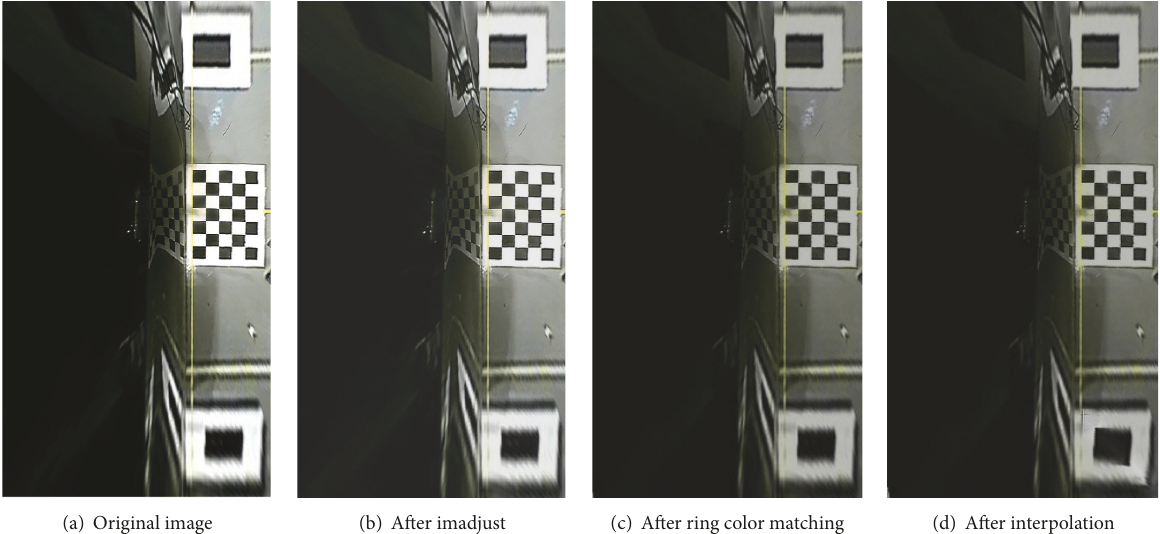
Figure 4: The image blending